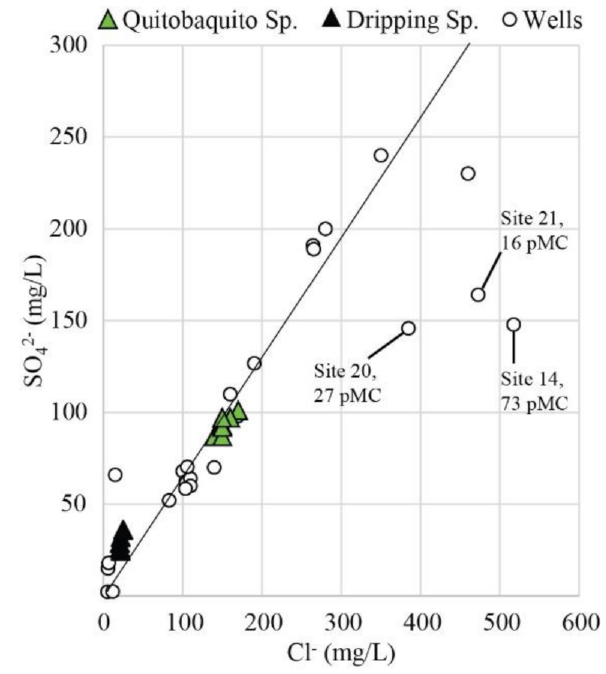
Figure 13. Cl − vs SO 42 − values for spring and well samples. Diagonal line shows hypothetical evaporation